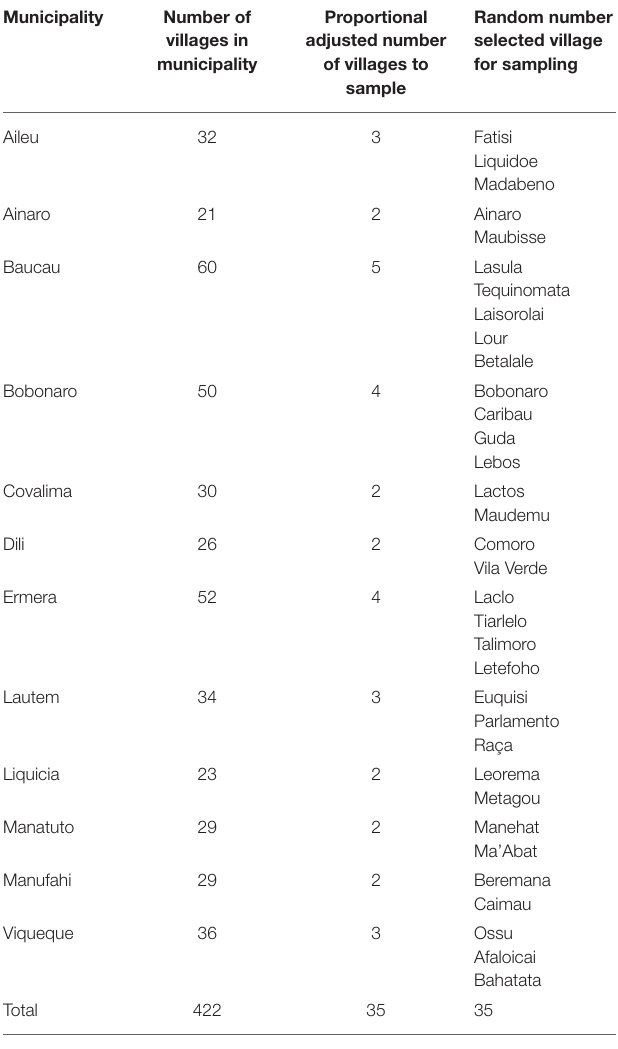
TABLE 1 | Timor-Leste municipalities and randomly selected villages for mainland ASFV prevalence survey.